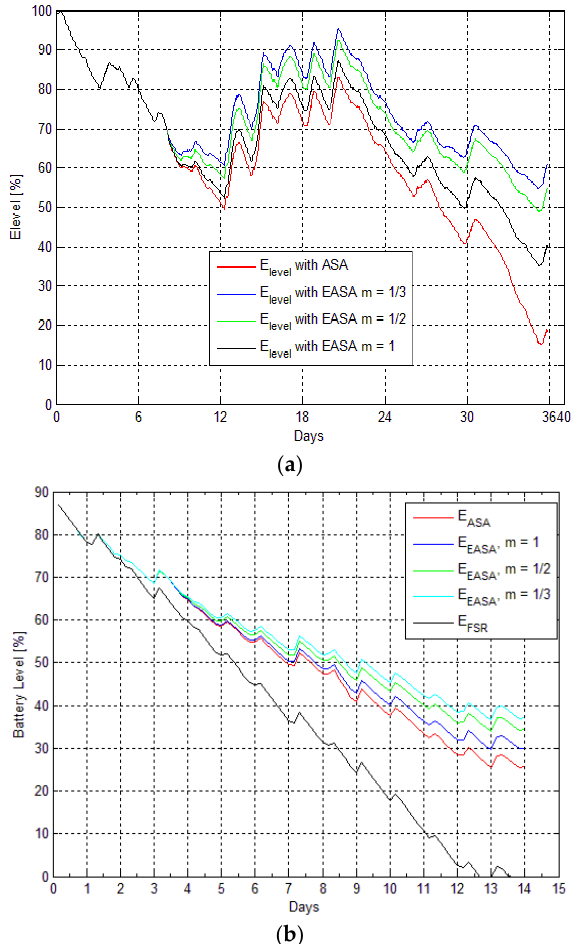
Figure 9. ( a ) Deployment (I): Energy in the system (ASA vs. EASA) as a function of time. ( b ) Deployment (II): Energy in the system (ASA vs. EASA) and fixed sampling rate energy level ( E FSR ) as a function of time.